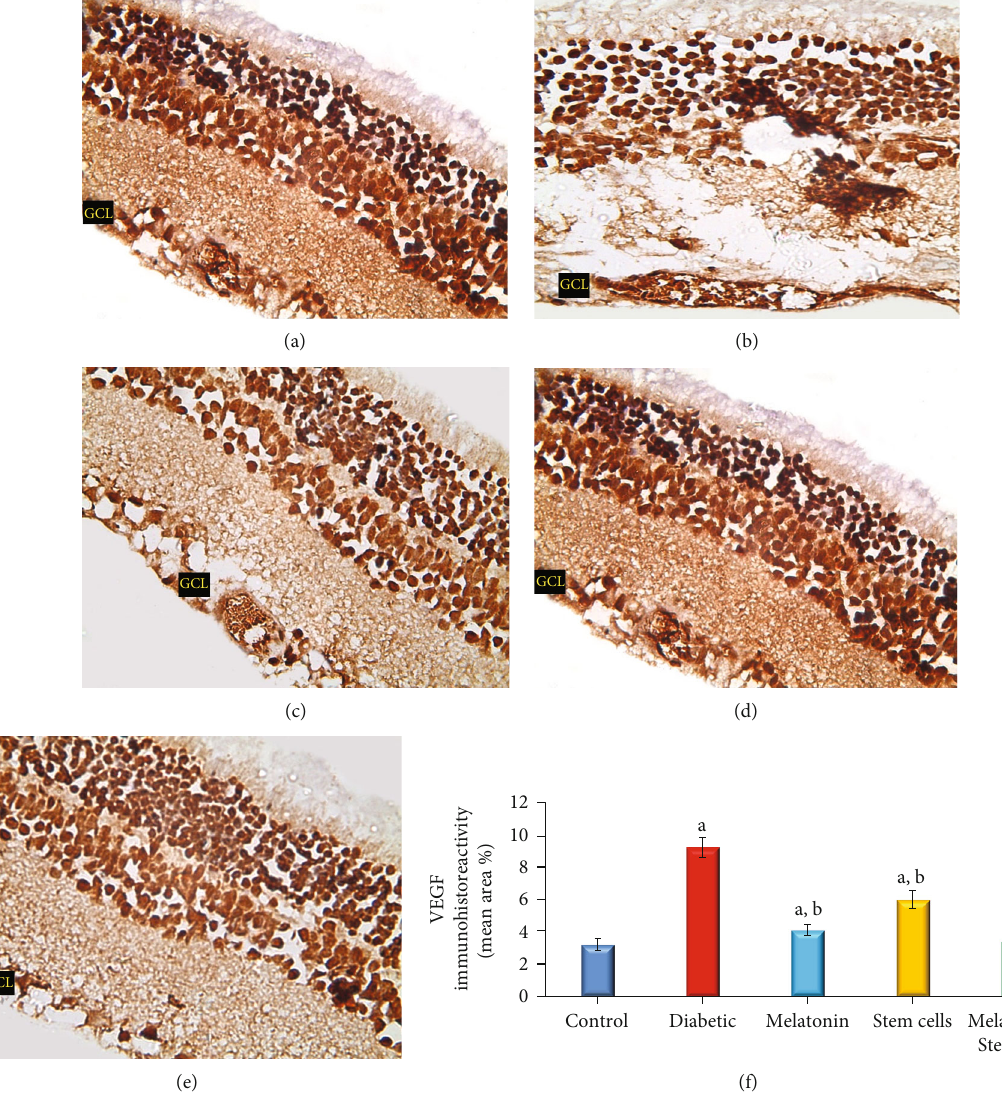
Figure 6: Photomicrograph of VEGF immunohistochemically stained retinal sections (magni fi cation, × 200). (a) The control group showed no immunoreactivity. (b) The diabetic group showed a strong positive VEGF immunoreactivity (brown color) in the ganglion cell layer (GCL). (c, d) Melatonin and stem cell groups, respectively, displayed a positive immunoreactivity (brown color) in GCL. (e) The melatonin+stem cell group showed a negative immunoreactivity. (f) The optical density of VEGF was represented as means ± SE ( n = 10 ). a indicates a signi fi cant di ff erence as compared to the control group at P < 0 : 05 . b indicates a signi fi cant di ff erence as compared to the diabetic group at P < 0 : 05